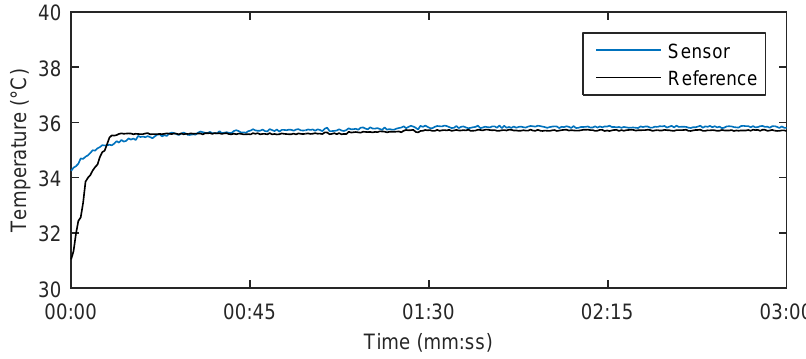
Figure 14. Body temperature measurement result in the test subject M1 for 180 s using our novel sensor system and reference digital